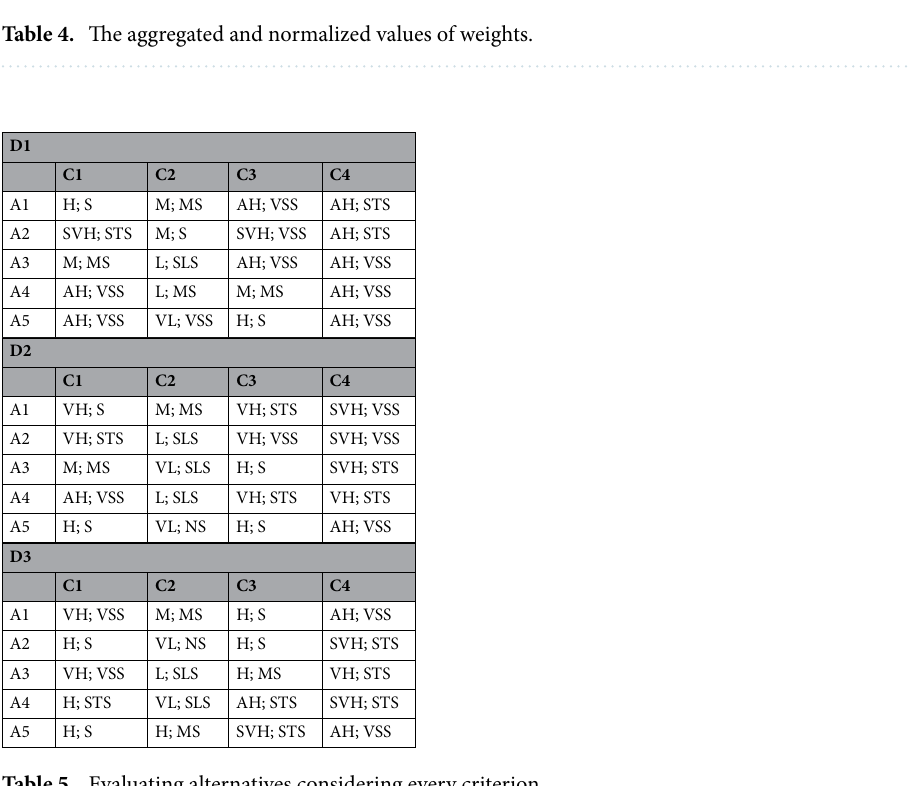
Table 5. Evaluating alternatives considering every